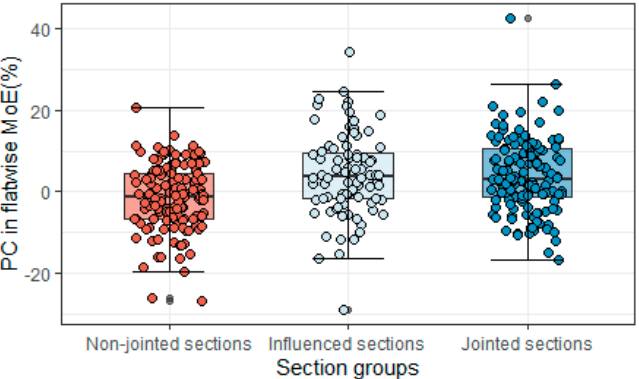
Figure 15. Percentage changes (PC) in flatwise MoE values of different groups of sections.